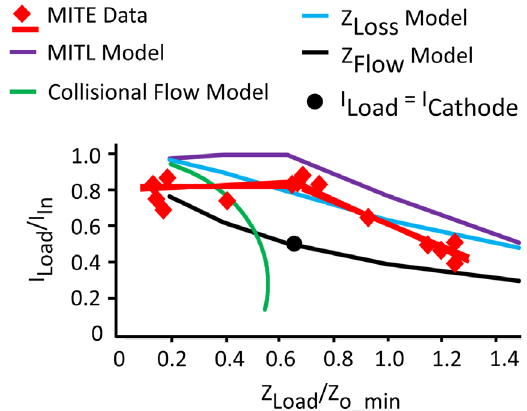
Fig. 3. Z is the minimum vacuum wave impedance o min in the MITL. The difference between the curve labeled MITE data and the curve labeled Z model in Fig. 3 is the substantial Flow retrapping of electron flow and contradicts the assumption of inefficient retrapping.